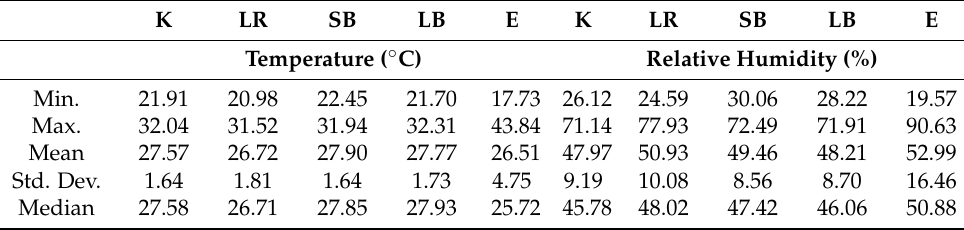
Table 1. Statistics of the measured temperature and relative humidity (K—kitchen, LR—living room, SB—small bedroom, LB—large bedroom, E—external balcony).